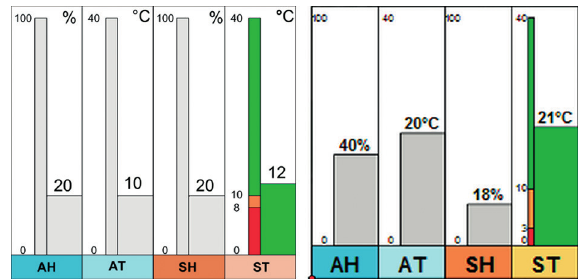
Fig. 4: Left: Propose of dynamically generated multivari- ate symbol for selected agricultural activity (in this case it is corn sowing). Right: The final form of the multivariate symbol (for context maize sowing). Air humidity (AH), air temperature (AT), soil humidity (SH), and soil temperature (ST) represent here the observed characteristics.